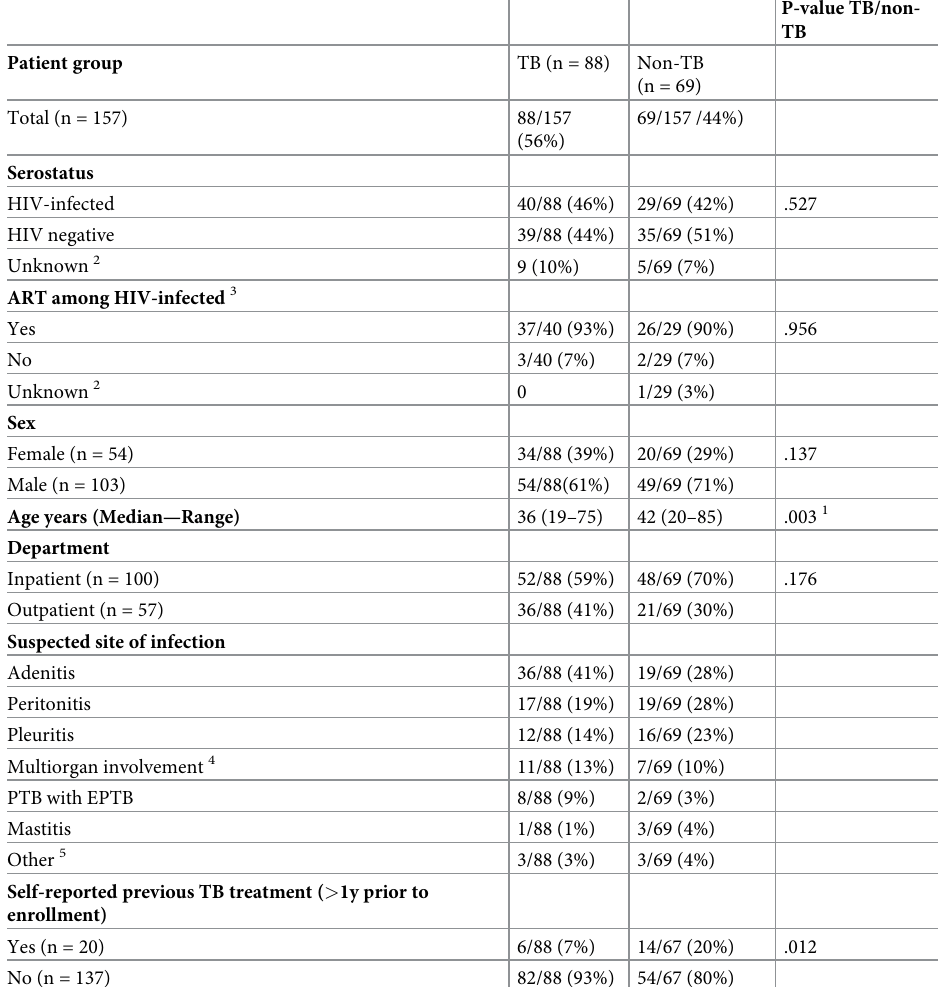
Table 1. Baseline characteristics of study participants grouped as TB and